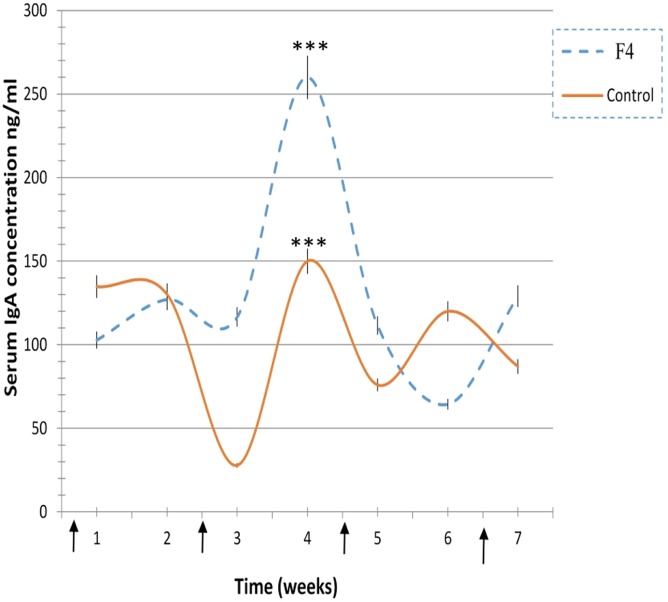
Immunoglobulin A (IgA) concentration levels. IgA concentration levels in laying hens from 23 to 42 weeks in the F4 (F4) and Control (C) groups. ***P < 0.001. Arrows indicate immunizations.